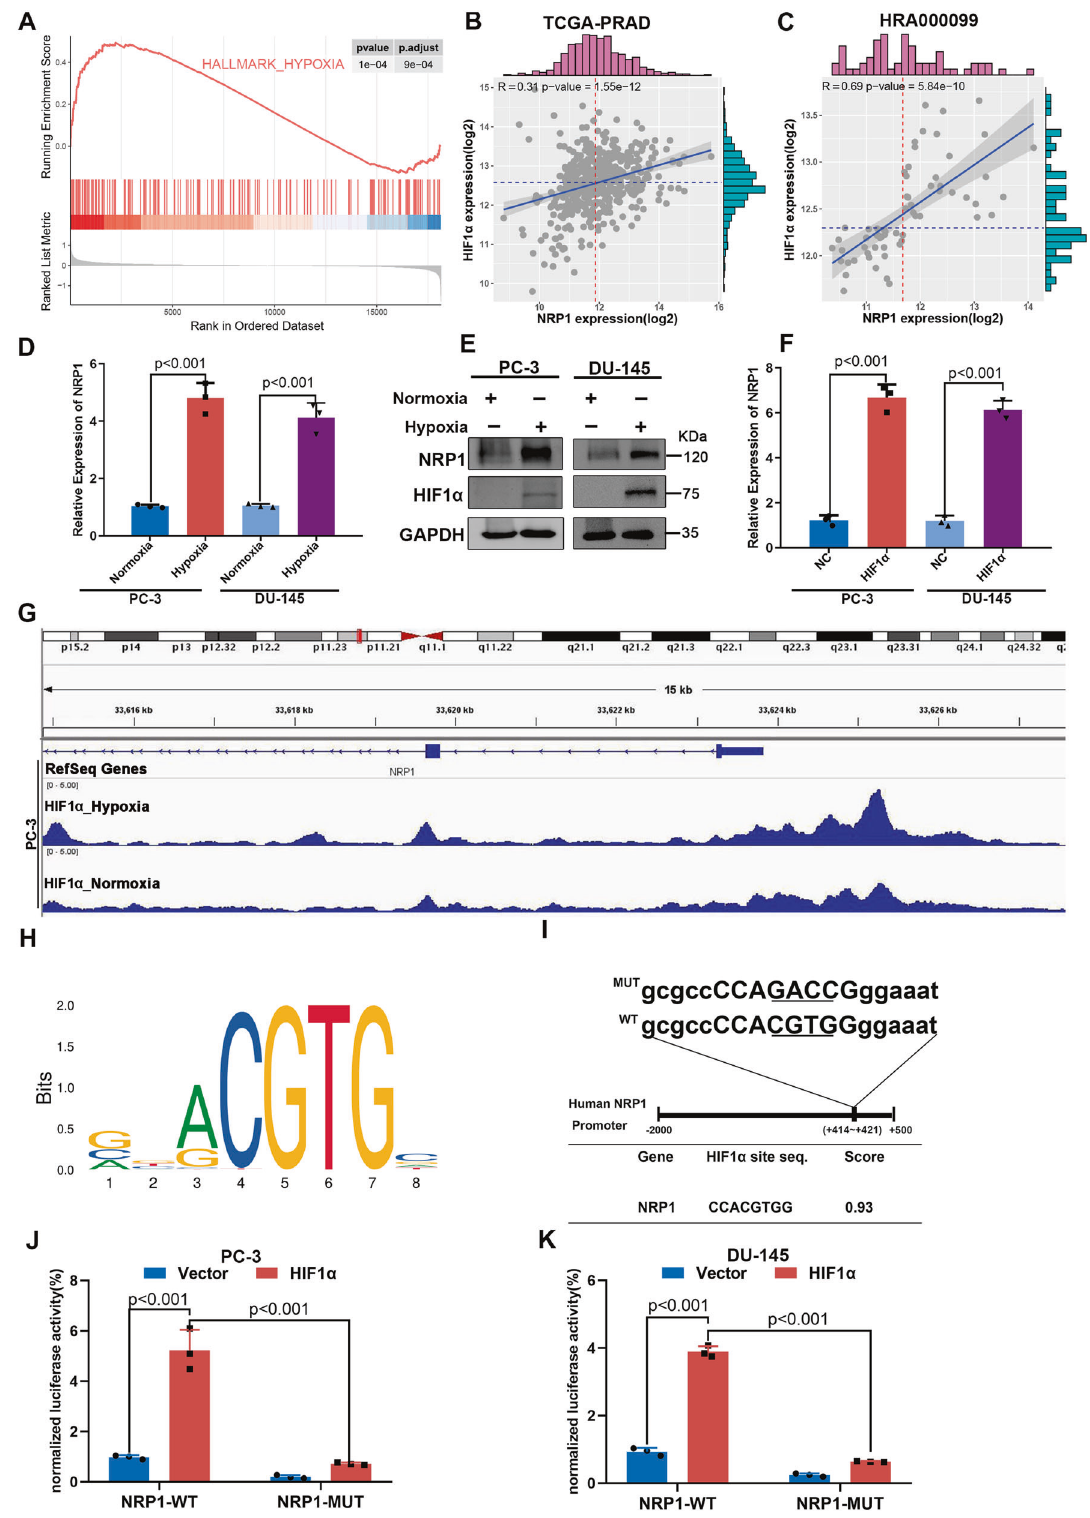
Fig. 2 HIF1 α increases the expression of the NRP1 gene through transcriptional activation in PCa cells. A GSEA analysis of the GSE70769 dataset indicated NRP1 is signi fi cantly associated with the hypoxia pathway. B , C HIF1 α expression is correlated with NRP1 expression based on the TCGA-PRAD and HRA000099 datasets. D Expression of NRP1 mRNA level increases under hypoxic conditions. E Signi fi cant increase in protein levels of HIF1 α and NRP1 in PCa cells under hypoxic conditions. F HIF1 α overexpression promotes NRP1 mRNA expression. G GSE106305 ChIP dataset indicates HIF1 α binding to the NRP1 promoter region shows a signi fi cant peak. H Schematic of canonical HIF1 α motif binding sites provided by the JASPAR database. I Diagram represents the predicted HIF1 α binding site on the NRP1 promoter, as well as wild-type/mutant NRP1 promoter plasmids. J , K Luciferase assay indicates that HIF1 α signi fi cantly increases NRP1-WT promoter-driven luciferase activity, while the mutation of the binding site of HIF1 α to NRP1 leads to signi fi cant attenuation of the luciferase activity in PC-3 and DU-145 cells, respectively. Values represent the mean ± SD of three independent experiments. Statistical signi fi cance was assessed using two-tailed t tests. Cell Death and Disease (2023)